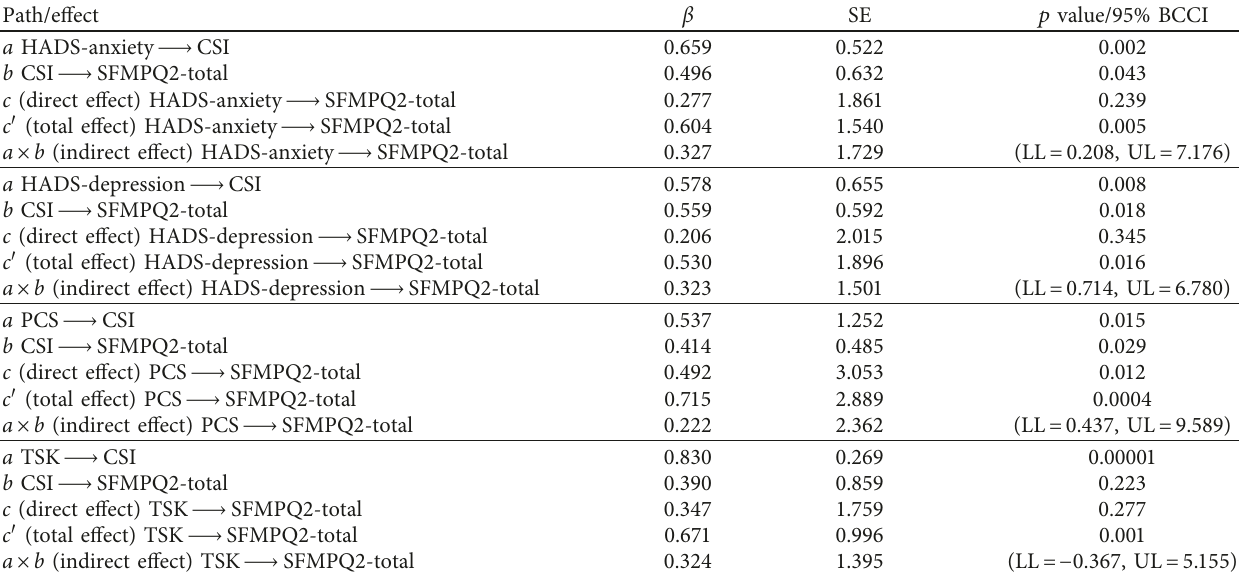
Figure 1: Central sensitization inventory (CSI) mediates the relationship between psychological factors and Short-Form McGill Pain Questionnaire 2 (SFMPQ2). Standardized betas are shown. (a) Hospital Anxiety and Depression Scale (HADS)-anxiety is the independent variable. (b) HADS-depression is the independent variable. (c) Pain Catastrophizing Scale-4 (PCS-4) is the independent variable. (d) Tampa Scale for Kinesiophobia-11 (TSK-11) is the independent variable. Table 2: Mediation analysis: the role of CSI as a